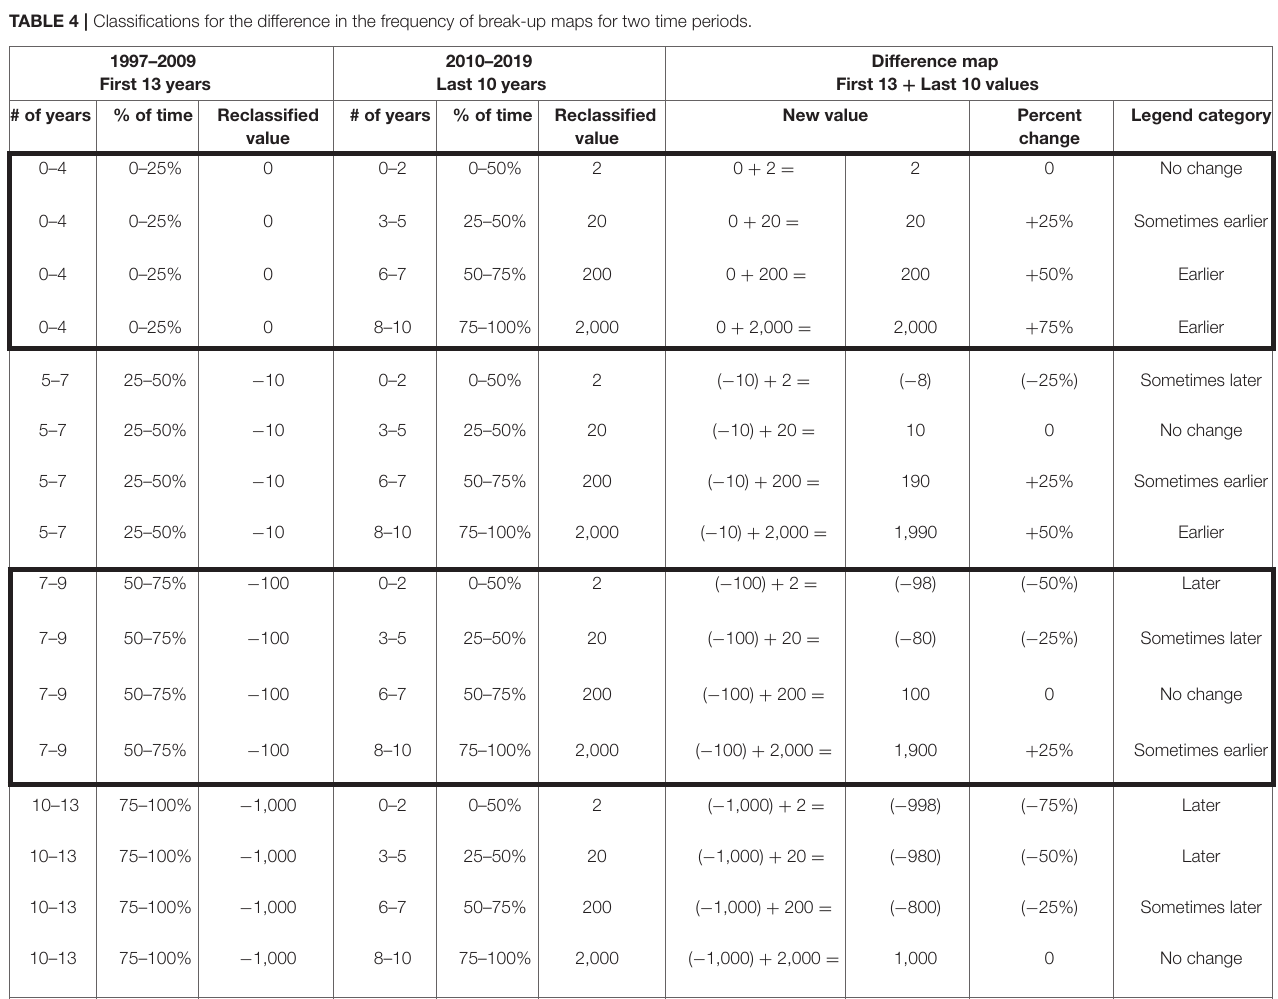
growth slows as it consolidates. These three, 2-week periods were merged reducing the number of classes for the yearly freeze-up maps to eight ( Table 5 ). A sequential three-color scheme used yellow for late October; green for November; blue for December; and dark blue for remaining areas of open water at the end of December ( Table 5 ; Brychtová et al., 2015). For the freeze-up and break-up yearly maps, the lightest colors indicate the areas in which sea ice is present for the longest period of time and the darkest colors where sea ice was present for the shortest amount of